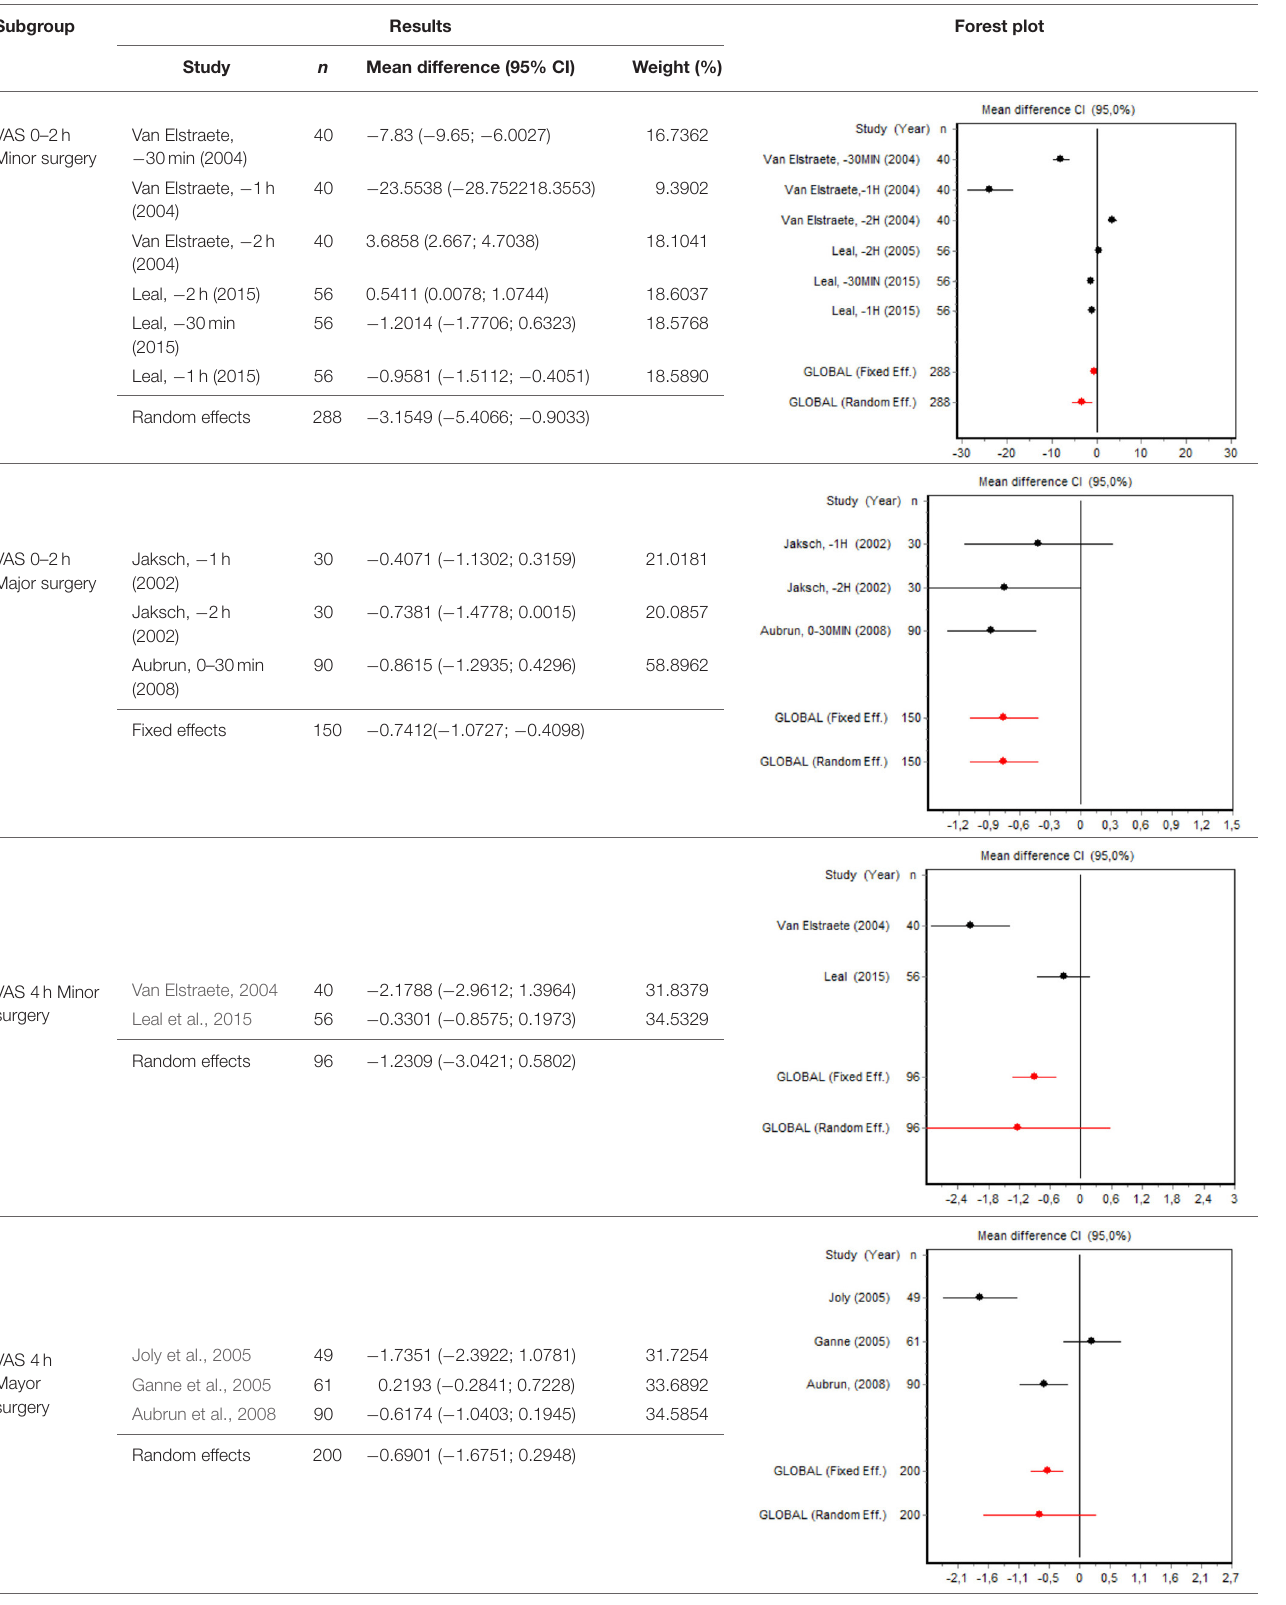
TABLE 4 | Meta-analysis results. Subgroup Results Forest plot Study n Mean difference (95% CI) Weight